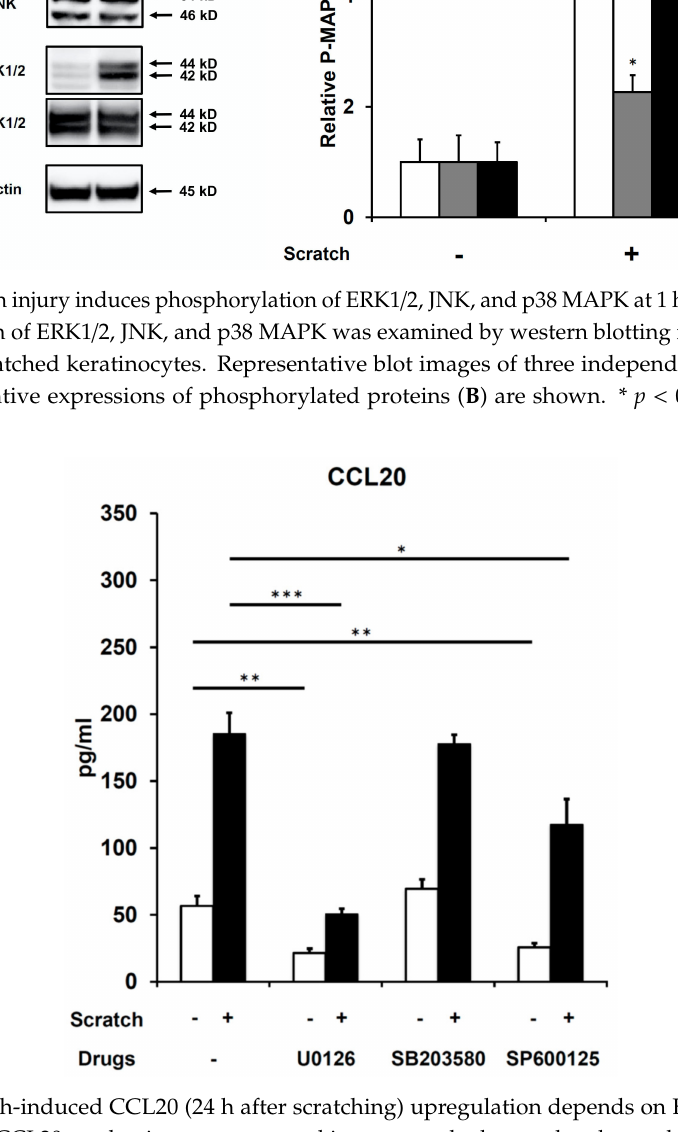
Figure 5. Scratch-induced CCL20 (24 h after scratching) upregulation depends on ERK1 / 2 and JNK activation. The CCL20 production was measured in nonscratched control and scratched keratinocytes in the presence or absence of U0126 (ERK1 / 2 inhibitor, 10 µ M), SB203580 (p38 MAPK inhibitor, 10 µ M), and SP600125 (JNK inhibitor, 10 µ M). Representative data of three independent experiments are shown. * p < 0.05. ** p < 0.01. *** p <